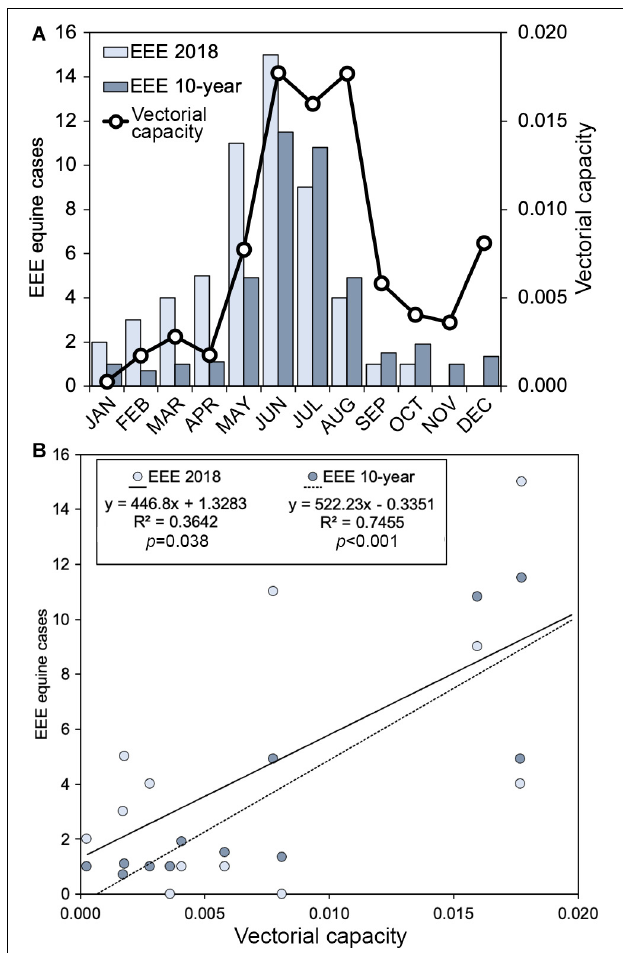
FIGURE 5 | Relationship of vectorial capacity of Cs. melanura for EEEV and equine cases from Florida. (A) Monthly values of vectorial capacity (black line) and EEEV cases in equines (bars); (B) Scatterplot of vectorial capacity and EEEEV cases in equines with best fit linear regression lines. Values of the vectorial capacity ( C ) were calculated using Cs. melanura collected from two Central Florida counties. EEEV cases are monthly aggregates for the year of Cs. melanura sampling (2018) or monthly averages over the prior